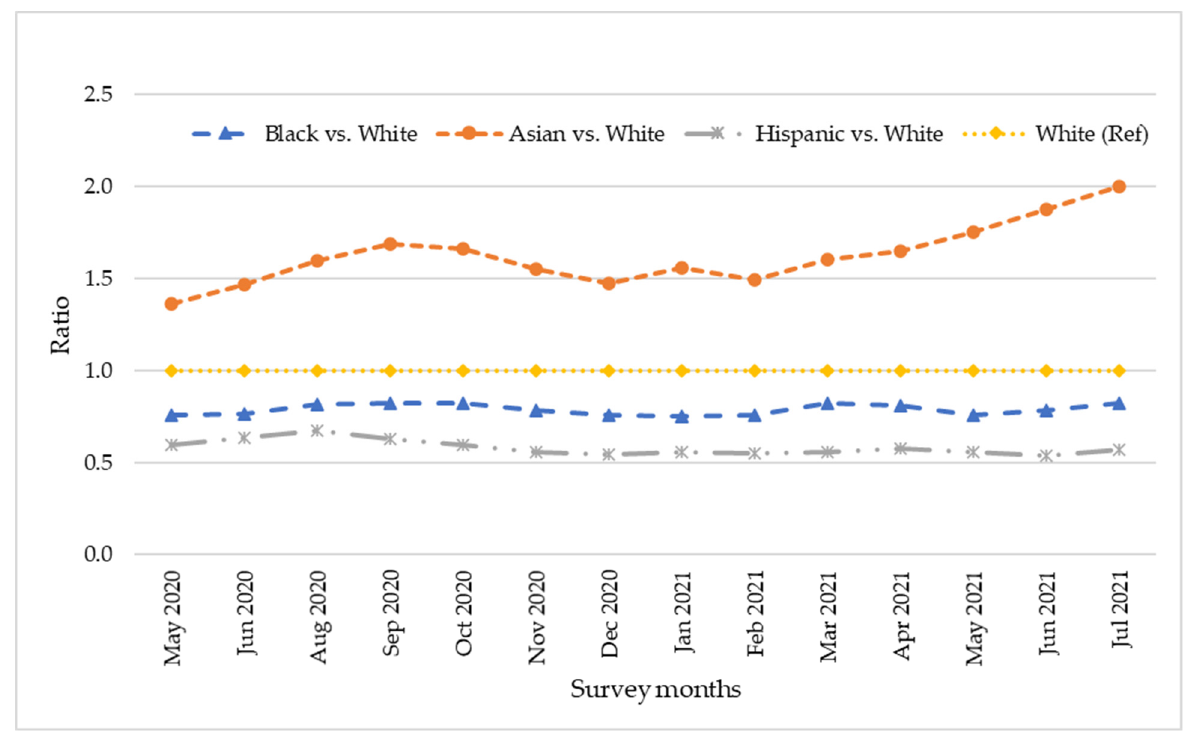
Figure 5. Ratio of Black, Asian, and Hispanic workers who teleworked relative to White workers who teleworked, by CPS survey months.